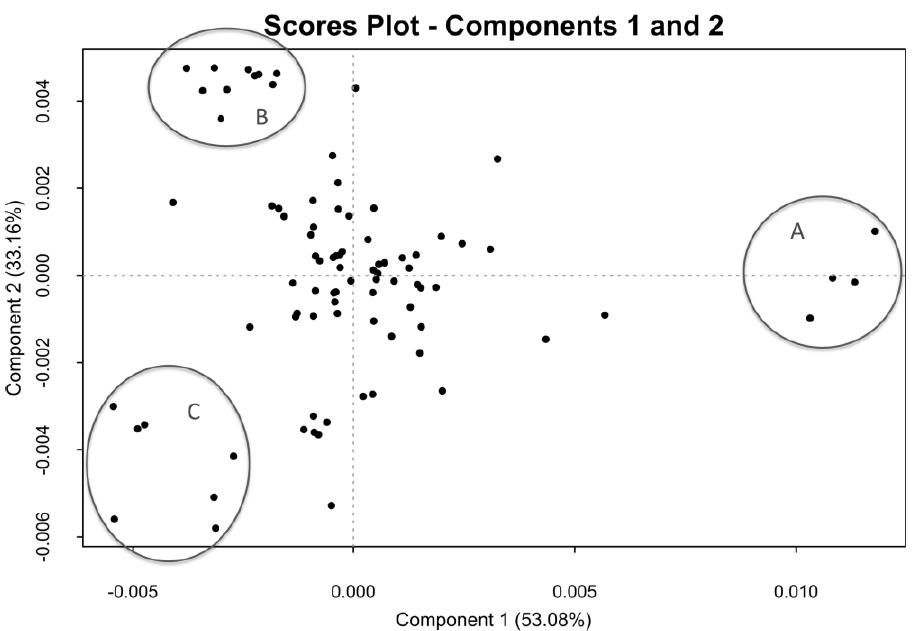
Figure 2. Score plot of the first two components generated by principal component analysis (PCA) of the GAGs signals region of the 1 H-NMR spectrum. Most of the samples are centered in the PCA, while there are 21 more peripheral samples: highlighted as A, B, and C.